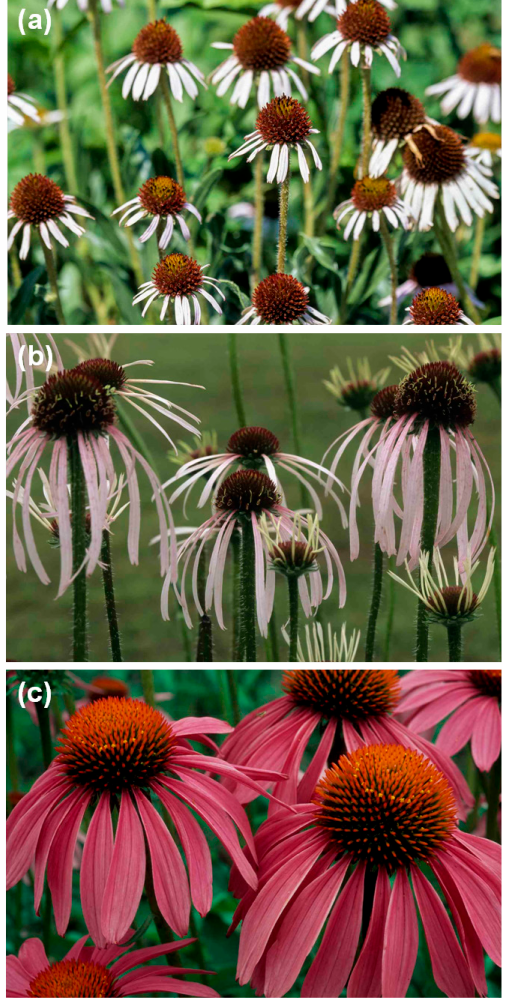
Figure 1. Photographs of the three Echinacea species: ( a ) E. angustifolia ; ( b ) E. pallida ; and ( c ) E. purpurea